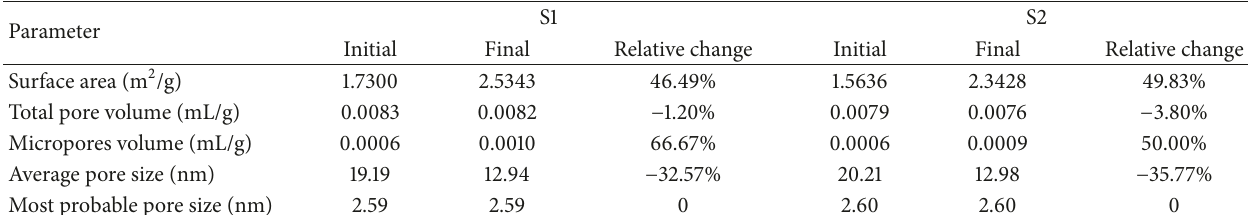
Table 4: Measured pore structure parameters of the rock samples before and after the